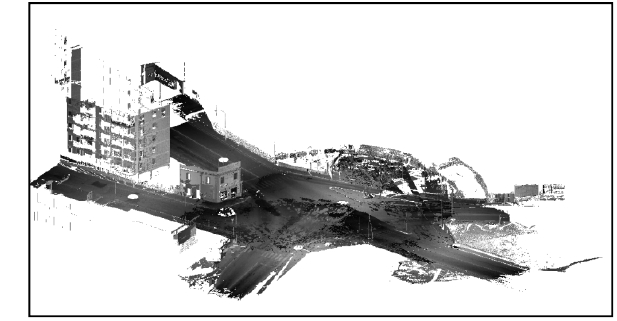
Figure 7. Model of the Piazza d’Armi square